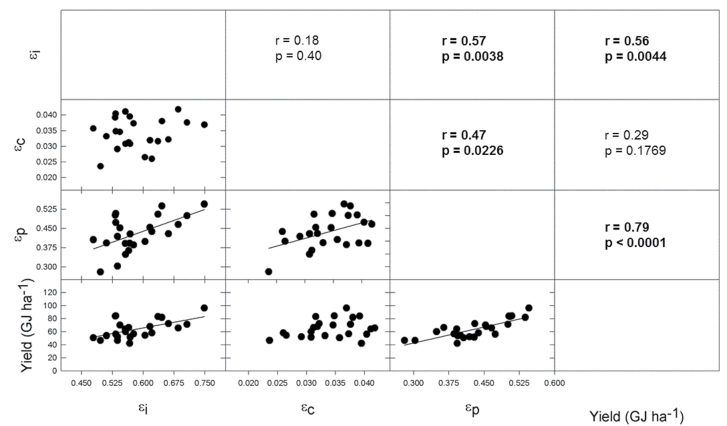
2013 correlation matrix of yield and Monteith efficiencies. εp is expressed in terms of biomass (g seed/g total aboveground biomass). Scatterplots and correlation coefficients are plotted in a matrix where lines represent significant least-squares regression. Bold indicates significant results.